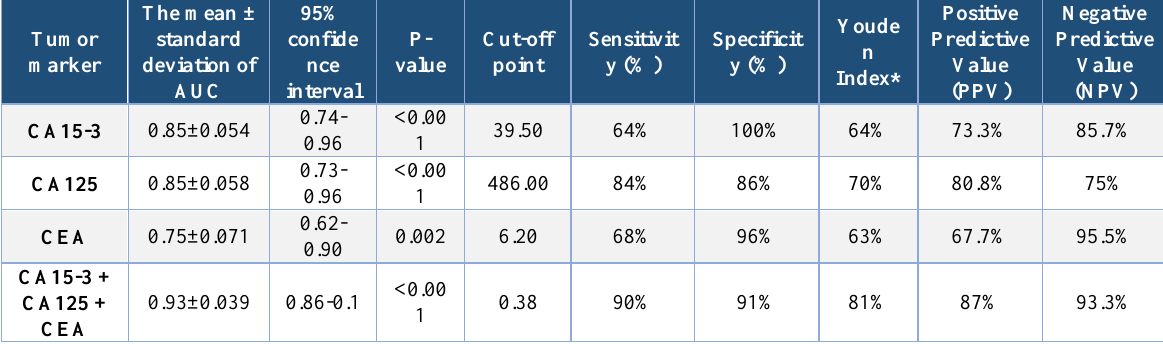
Table 5 . Diagnostic value of single tumor marker and the combination of complementary triple